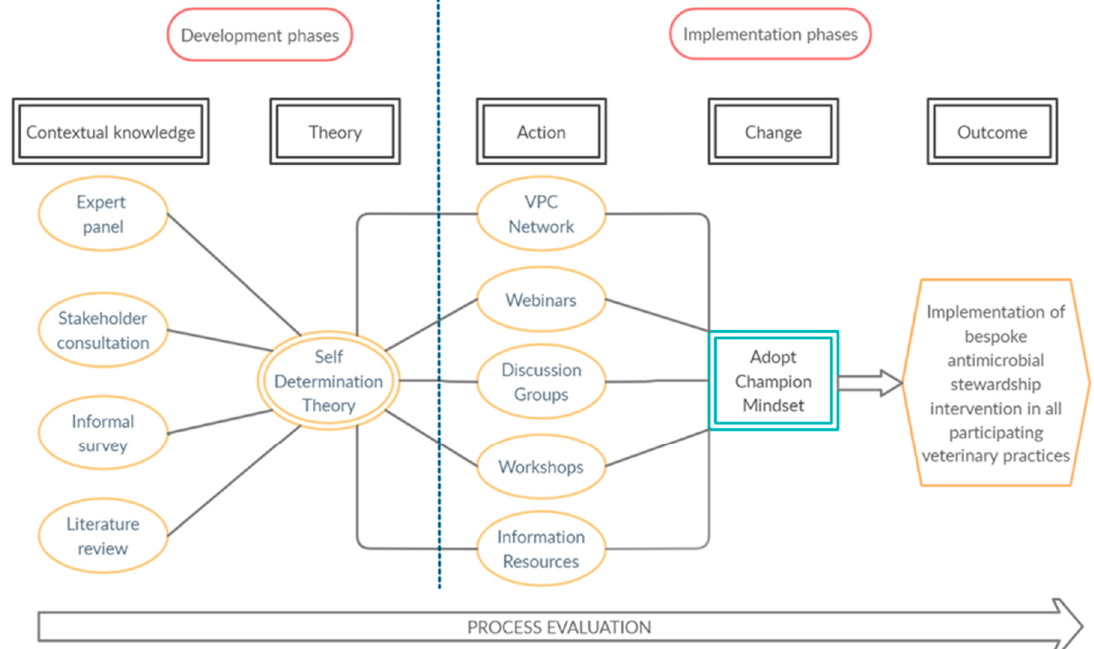
Figure 2. Design map of the Arwain Vet Cymru program, identifying the key phases of the design and implementation